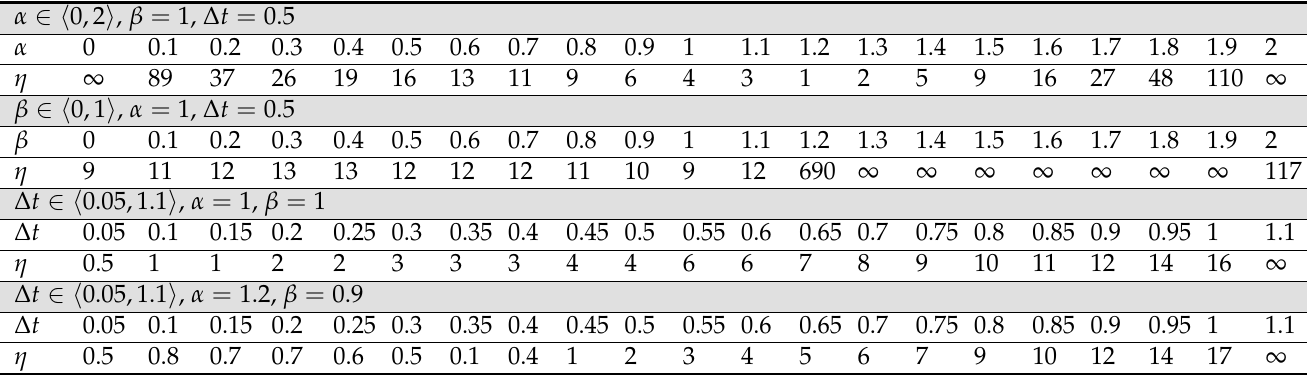
Table 1. Mean relative error η , in percent, between theoretical and simulated susceptibility, calculated in the range ω ∈ ( 0.3 ω p ,1 ω p ) , for various values of parameters α , β and the time step ∆ t ; infinity ( ∞ ) indicates that the approach loses stability and no results are